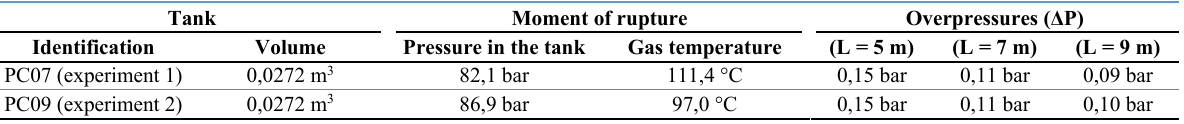
Table 6. Experimental data from Tschirschwitz et al. [22].